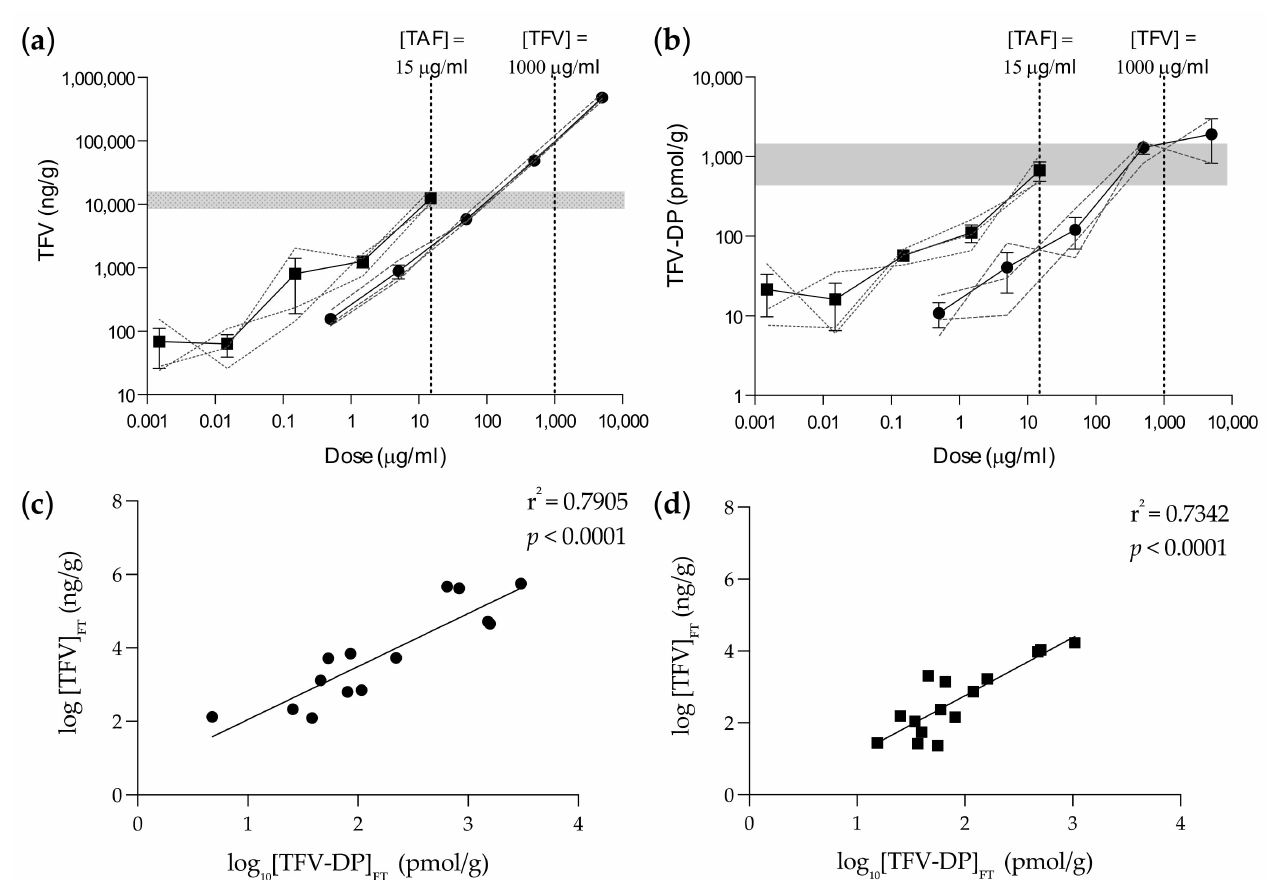
Figure 2. PK analysis. Foreskin tissue explants were dosed with serial dilutions of TFV ( • ) or TAF ( (cid:4) ). TFV ( a ) or TFV–DP ( b ) concentrations were measured in explants 48 h after ex vivo dosing. Dotted lines indicate concentrations of TFV and TAF where equivalence with TFV–DP is observed (grey band in b ). Dotted grey band ( a ) indicates the level of TFV measured following dosing with TAF. Pearson correlation analysis was performed between explant concentrations of TFV and TFV–DP following dosing with TFV ( c ) or TAF ( d ). Data are the means (SEMs) from independent experiments performed in triplicate with specimens from three donors. FT: Foreskin